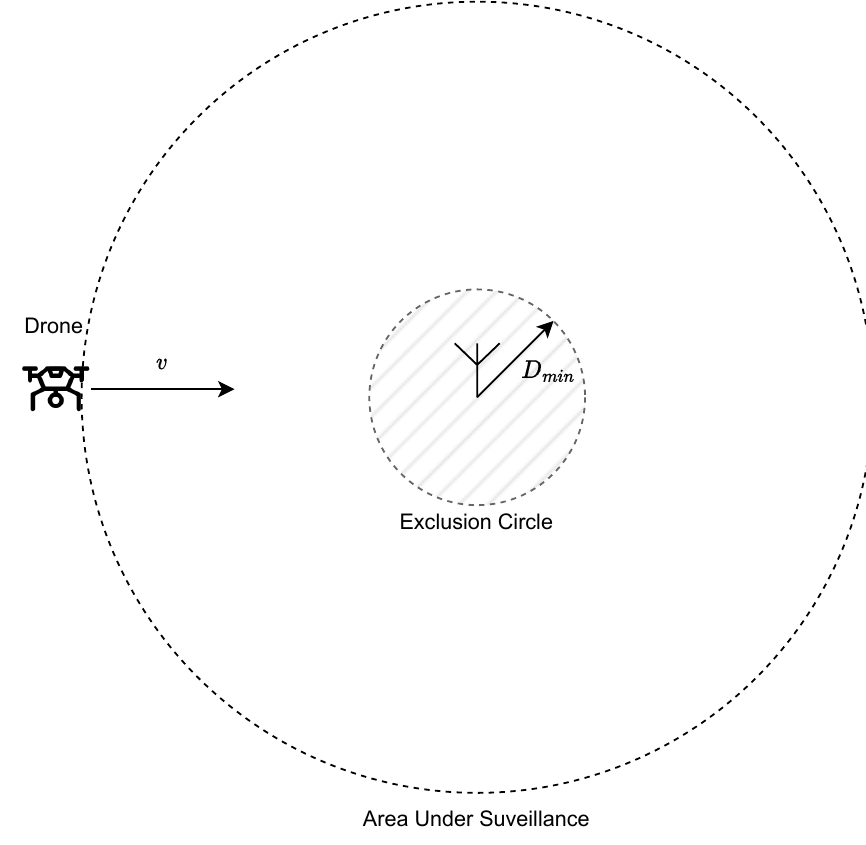
Figure A1. Exclusion circle of monitoring